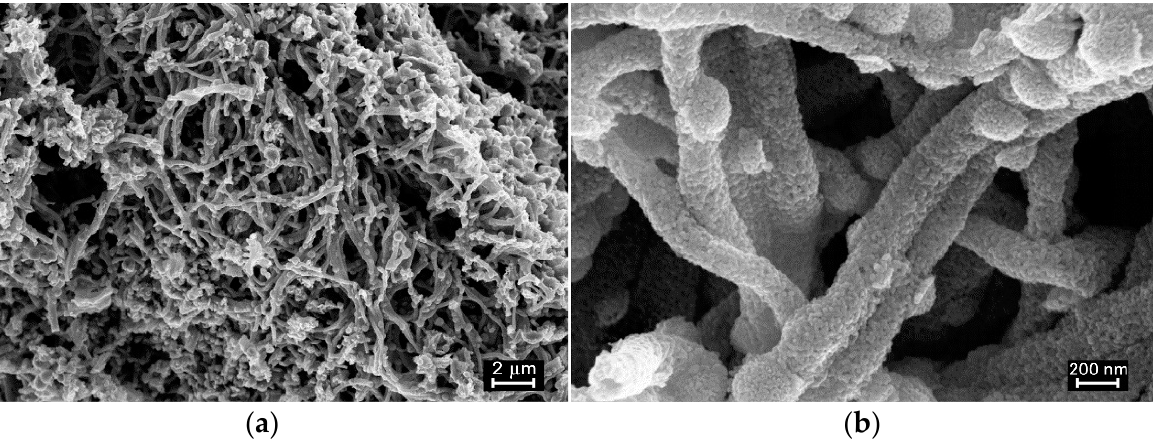
Table 1. Summary of ZnO and ZnO/Pd nanofibers characteristics [36].